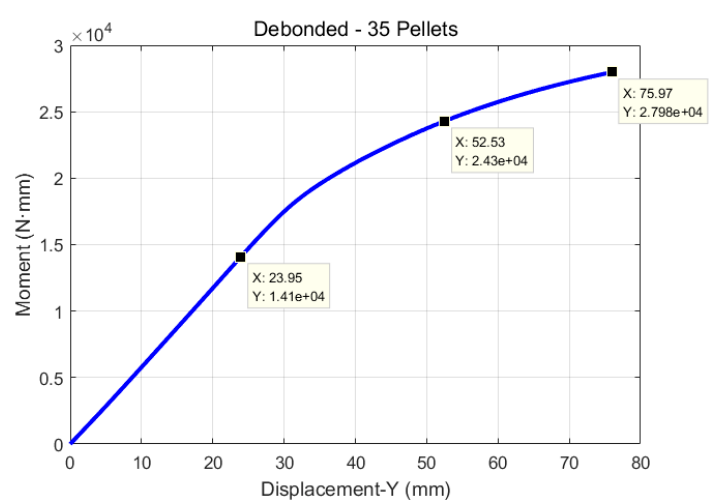
Figure 8. Moment versus maximum displacement diagram (fully bonded case).